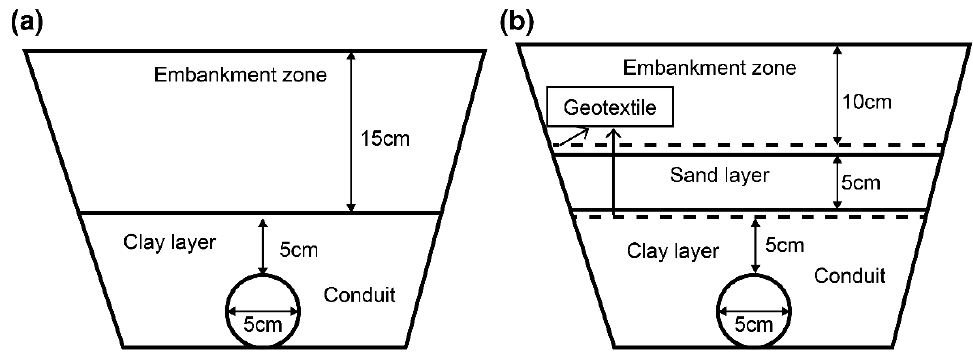
Figure 2. Comparison between conduit models: ( a ) current model, ( b ) proposed improvement model.